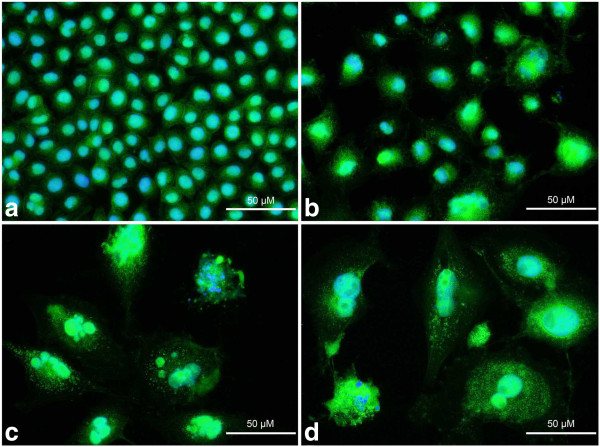
a-d Localization of G-actin in A549 cells after treatment with etoposide - fluorescence microscopic examination (labeling with DNase I). a Control cells, b 0.75 μM etoposide, c 1.5 μM etoposide, d 3 μM etoposide. Visible aggregation of G-actin in the perinuclear area after the treatment, as well as an increased number of G-actin-positive dot-like and vesicle-like structures in the cytoplasm. The intense fluorescence patterns indicative of cells with DNA fragmentation. Nuclei were counterstained with DAPI. Results are indicative of five independent experiments. Bar 50 μm.